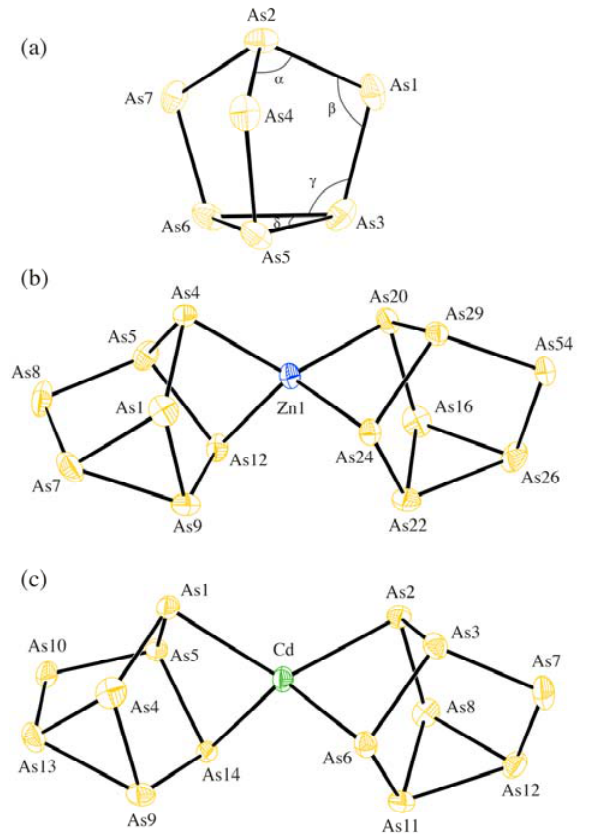
Figure 3. Representations of the [As ZnAs (b) , and the [CdAs Cs 4 14 drawn at the 50% probability